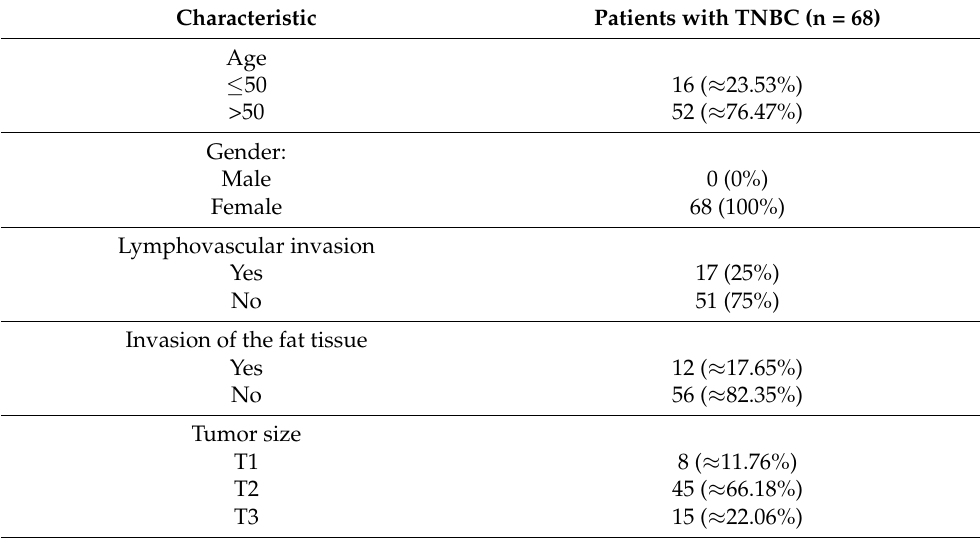
Table 4. Characteristics of 68 patients qualified for the